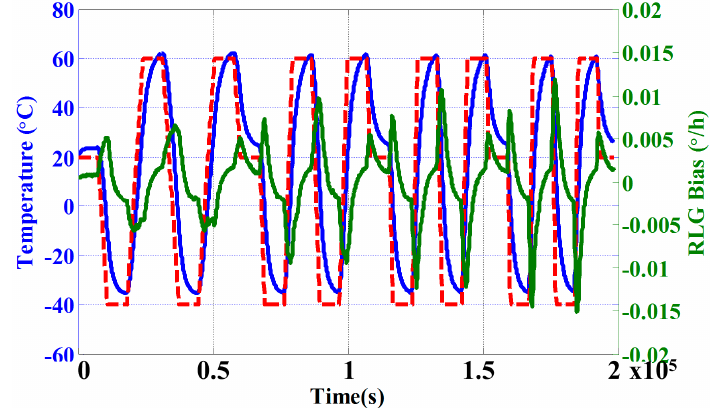
Figure 4. Temperature chamber setting with RLG bias and temperature.